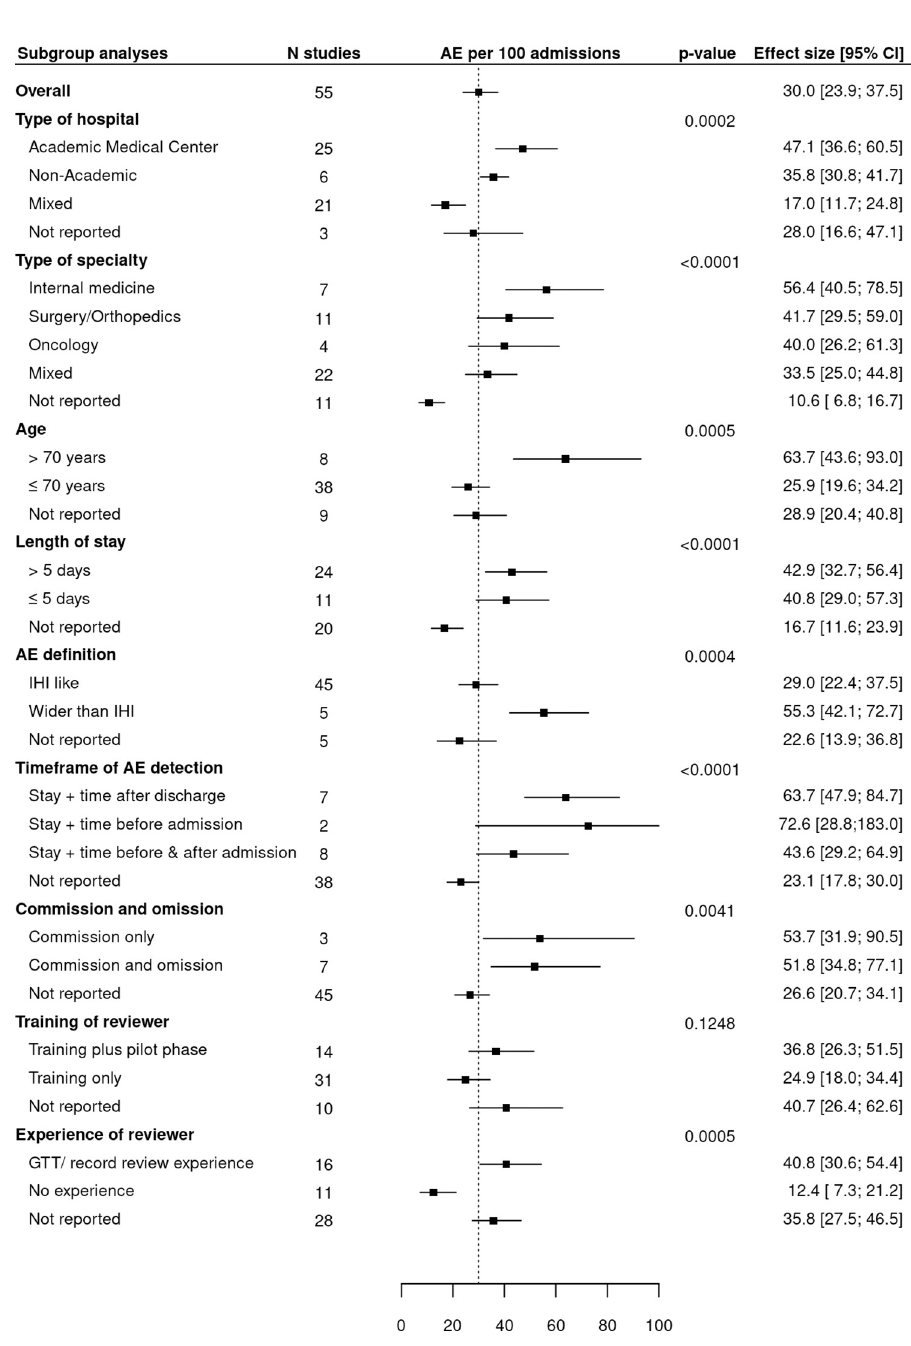
Fig 4. Forest plot with stratified analysis of the nine selected study characteristics. (AE, adverse event; CI, confidence interval; GTT, Global Trigger Tool; IHI, Institute for Healthcare Improvement; N Studies, number of